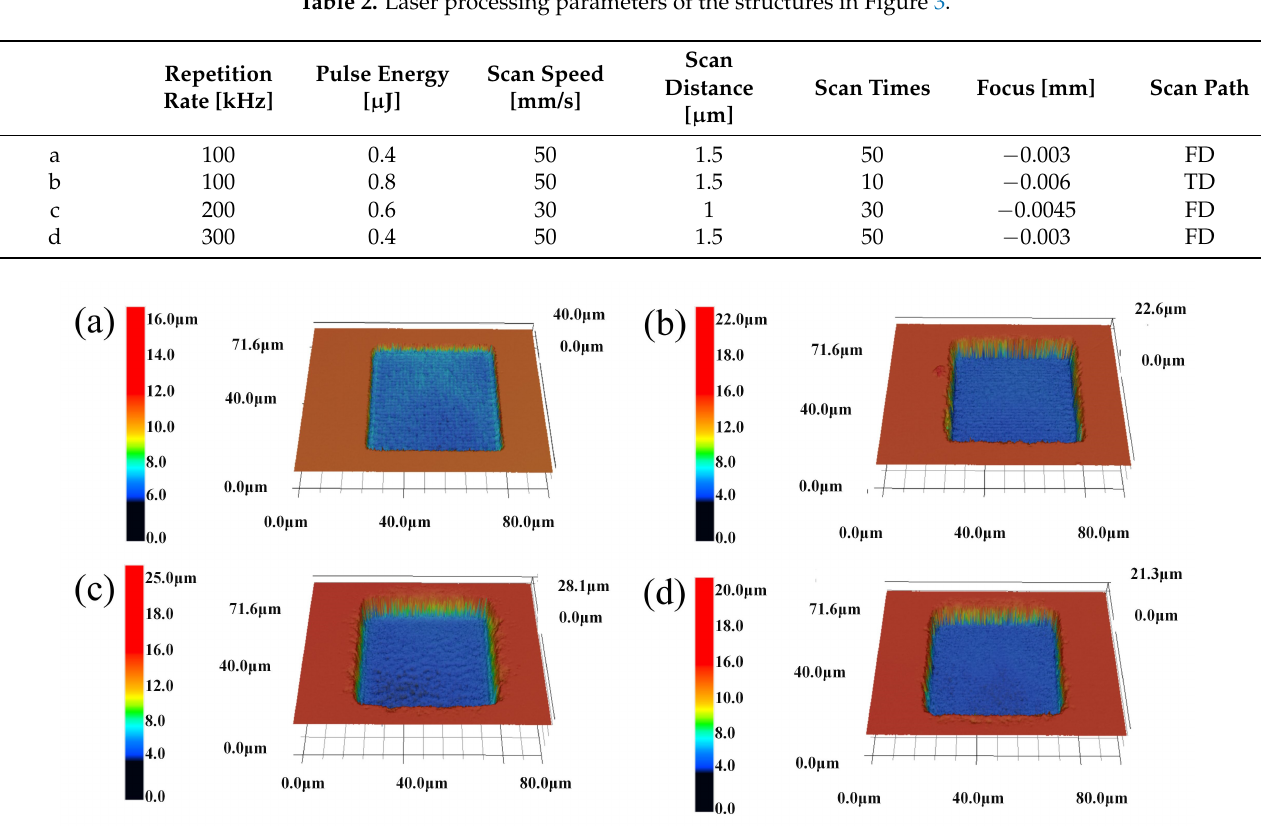
Table 2. Laser processing parameters of the structures in Figure 3.